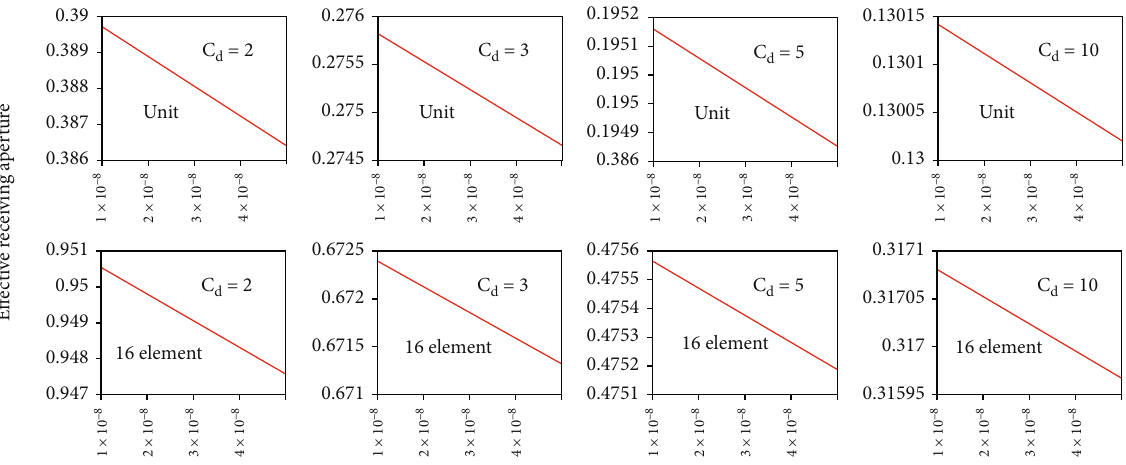
Figure 4: LiDAR receiver dead time and e ff ective receive aperture